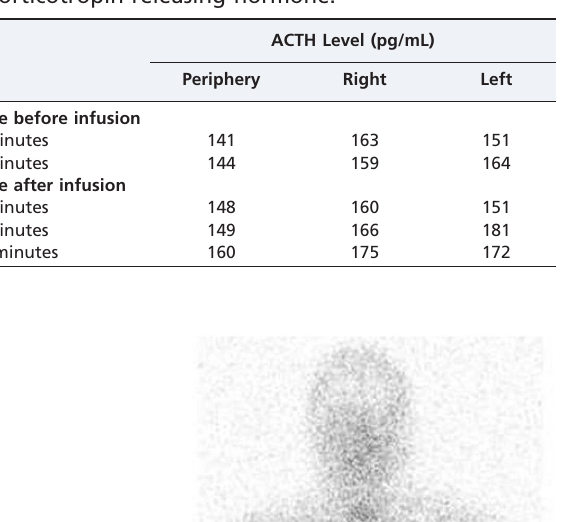
Table 1 - Adrenocorticotropic hormone (ACTH) levels in the inferior petrosal sinus before and after the infusion of corticotropin-releasing hormone.